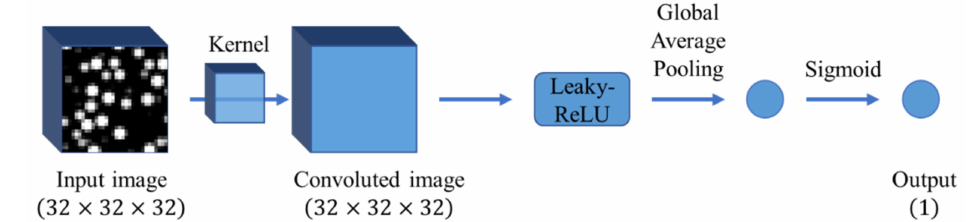
Figure 10. CNN architecture utilized in this work. The numbers in parentheses represent the dataset sizes. The input image of 32 × 32 × 32 pixels is convoluted into the image of 32 × 32 × 32 pixels under the periodic boundary conditions with a single kernel. The leaky ReLU function and global average pooling were applied to the convoluted image to reduce the dimension. Finally, the probability of the positive example is output using the sigmoid function.